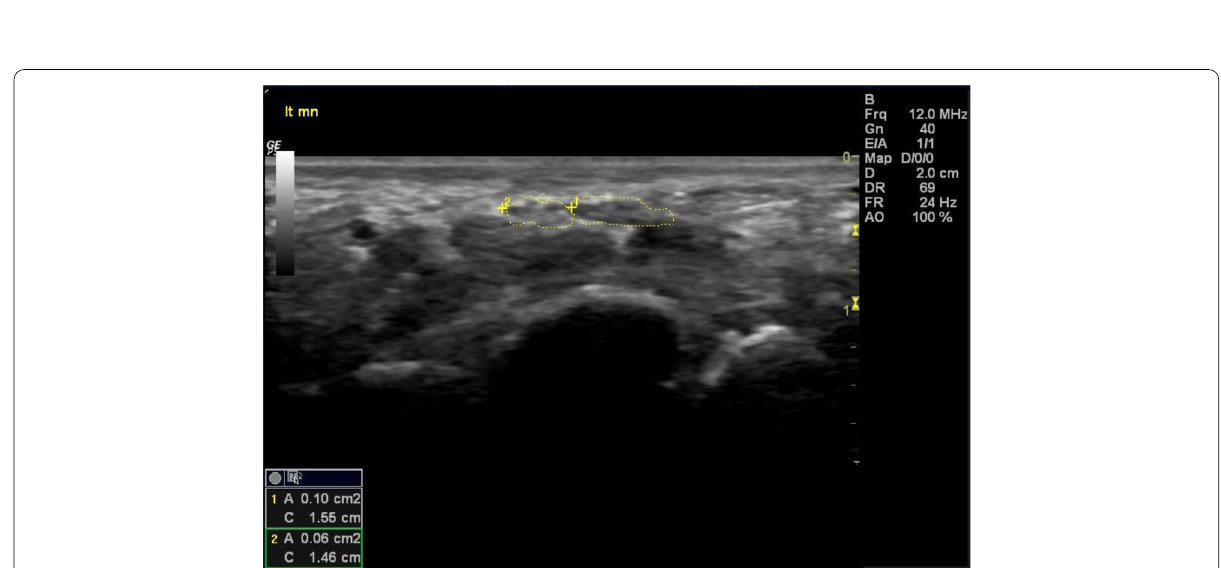
Fig. 6 Ultrasound of patient with disease activity score (DAS28) cross‑sectional area (CSA) (16mm 2